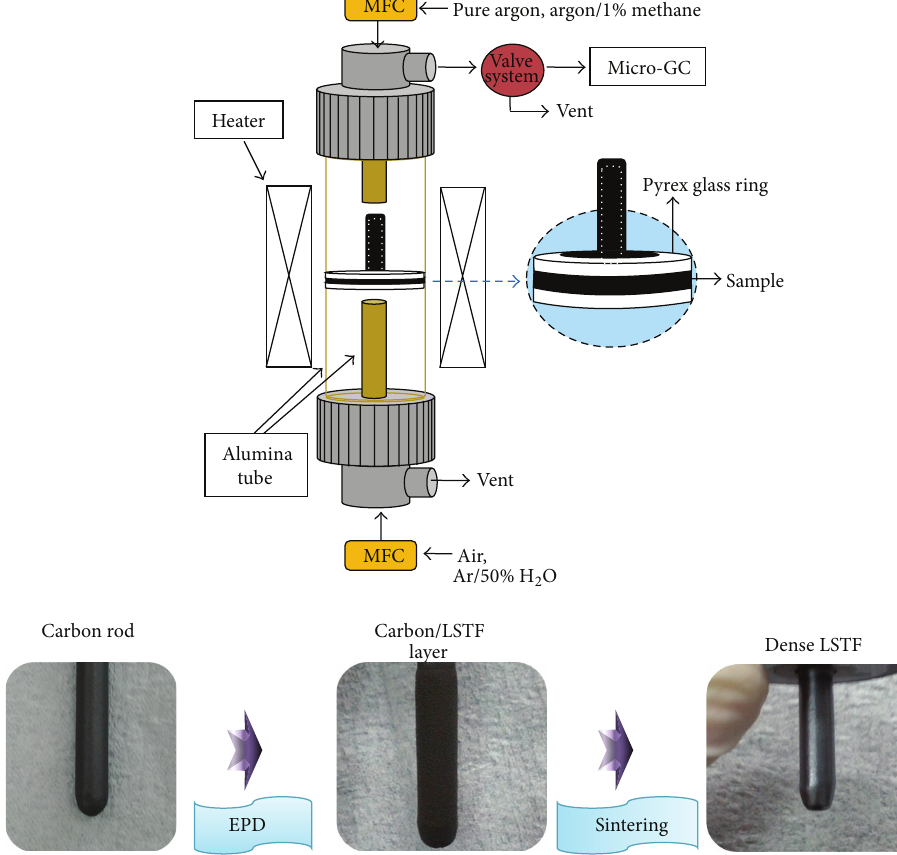
Figure 2: Characterization set-up for the oxygen permeability measurement and photo images of the microtubular membrane.